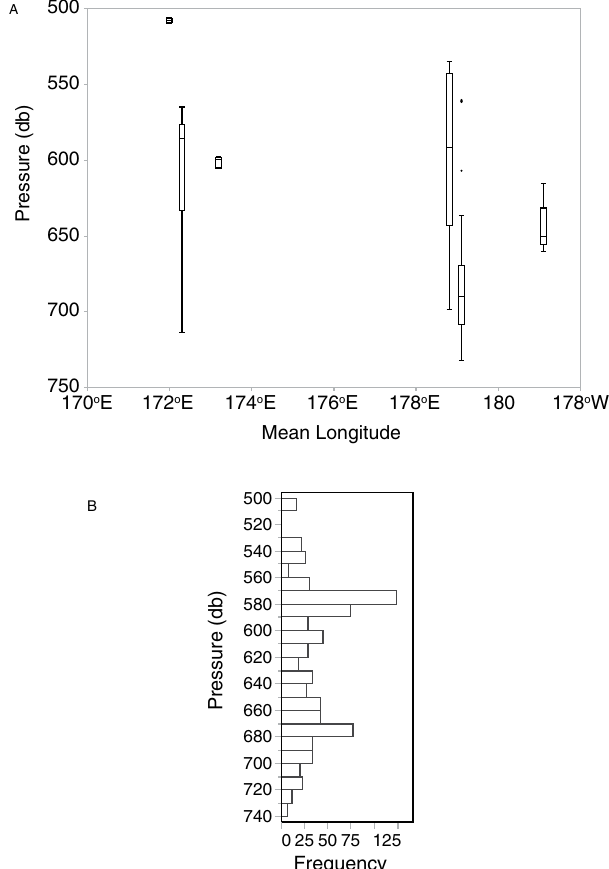
Figure 3. Distribution of observed scleractinian reef with depth and longitude. ( A ) Box plot based on number of images with reef present at each depth. ( B ) Histogram showing frequency of occurrence within each depth bin across